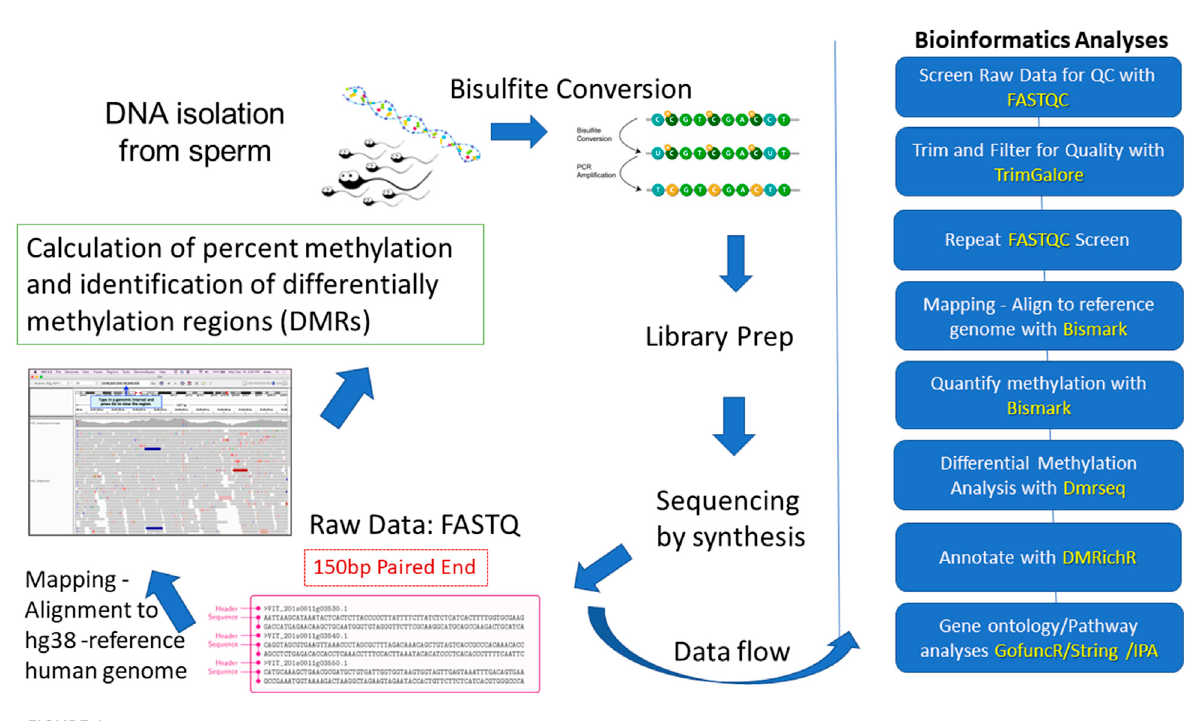
FIGURE 1 Overviewofwork fl owforthisstudy.Theblueblocksontherightoutlinetheanalyticalwork fl owandprograms(identi fi edbyyellowfont)usedto identify and characterize the